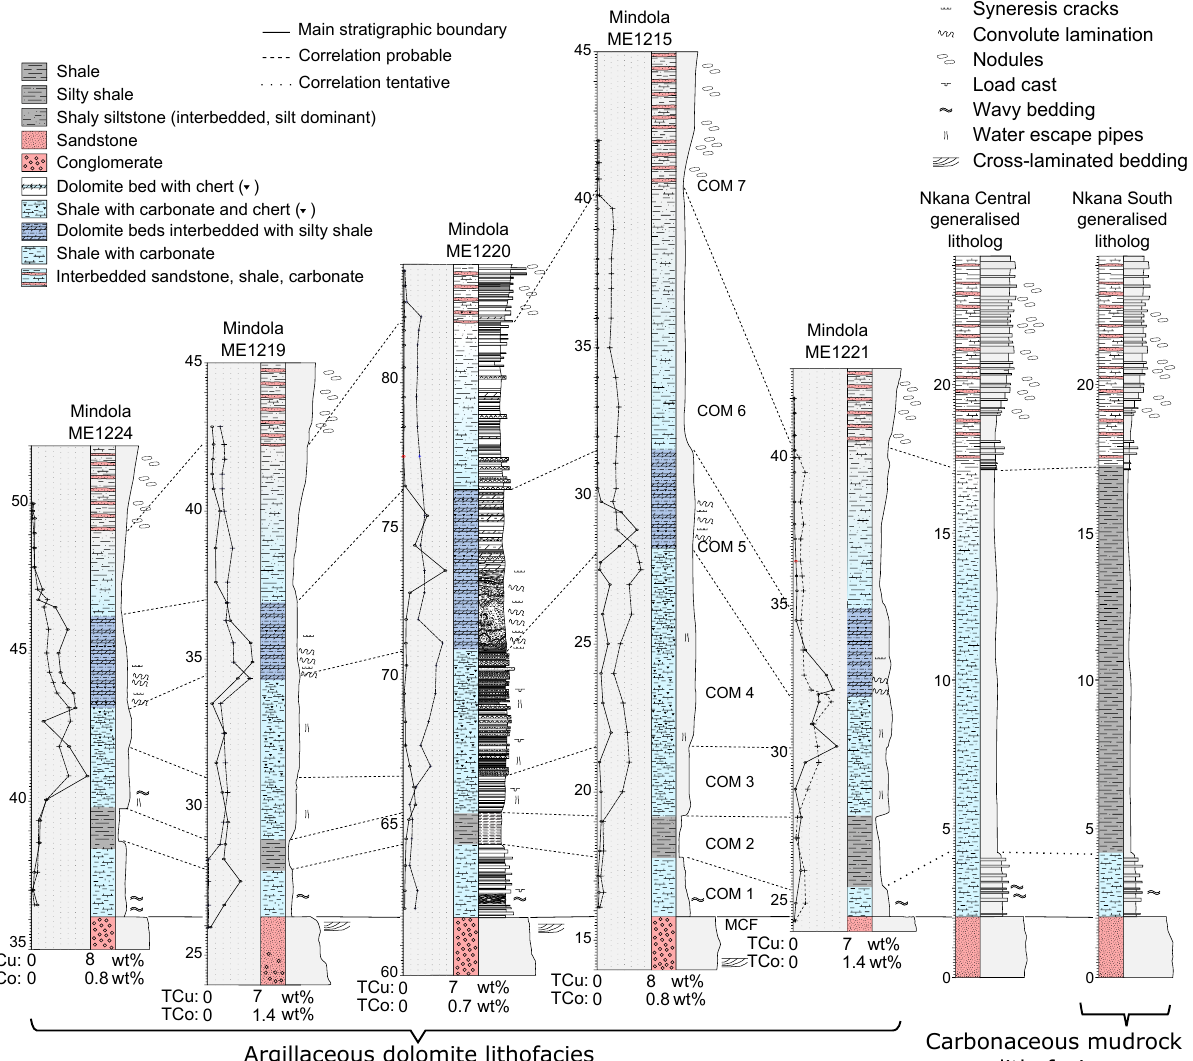
Figure 5. Lithologs of sections at Mindola (typical argillaceous dolomite), Nkana Central and Nkana South (typical carbonaceous mudrock). Log at Mindola is from boreholes, whereas only composite generalised lithologs are shown for Nkana South and Nkana Central because of the deformed nature COM there. Correlations are based on observed lithological contacts. Total Cu and Co values in percent are given in blue and red respectively, reproduced from data provided by Mopani Copper Mines Plc. These analyses were carried out on drill core halves in sections generally 10 to 15cm long and averaged over the length of the section. MCF: Mindola Clastics Formation; COM: Copperbelt Orebody